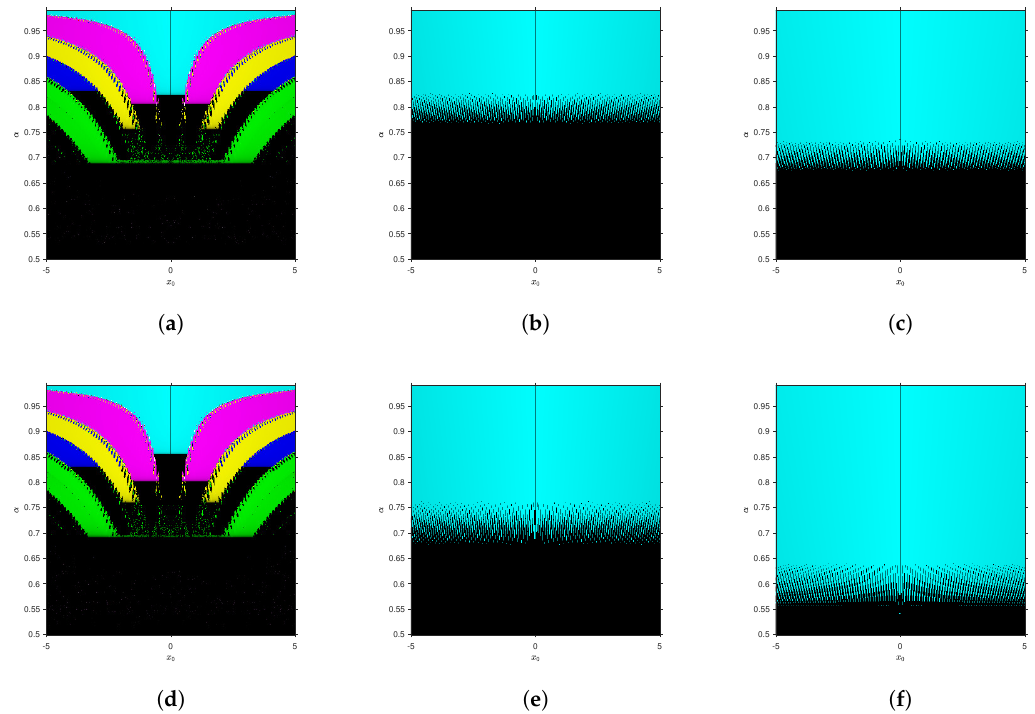
Figure 5. Convergence planes of fractional Newton and Traub-type methods on f 3 ( x ) with Re ( x 0 ) = 0 and − 5 ≤ Im ( x 0 ) ≤ 5. ( a ) CFN 1 , 45.2% convergence; ( b ) CFN 2 , 39.85% convergence; ( c ) CFT, 58.78% convergence; ( d ) R-LFN 1 , 44.28% convergence; ( e ) R-LFN 2 , 55.66% convergence; ( f ) R-LFT, 80.97%